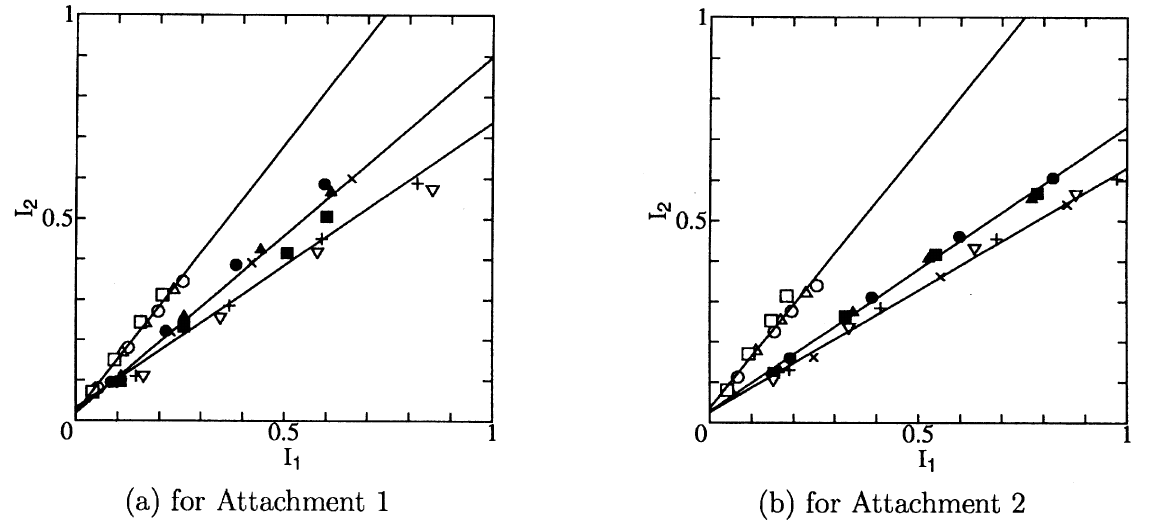
◦ • , (cid:5) , (cid:3) ), plastic foam ( , (cid:6) , (cid:1) ) and vulcanized Table 2 Variation of regression coefficients b and correlation